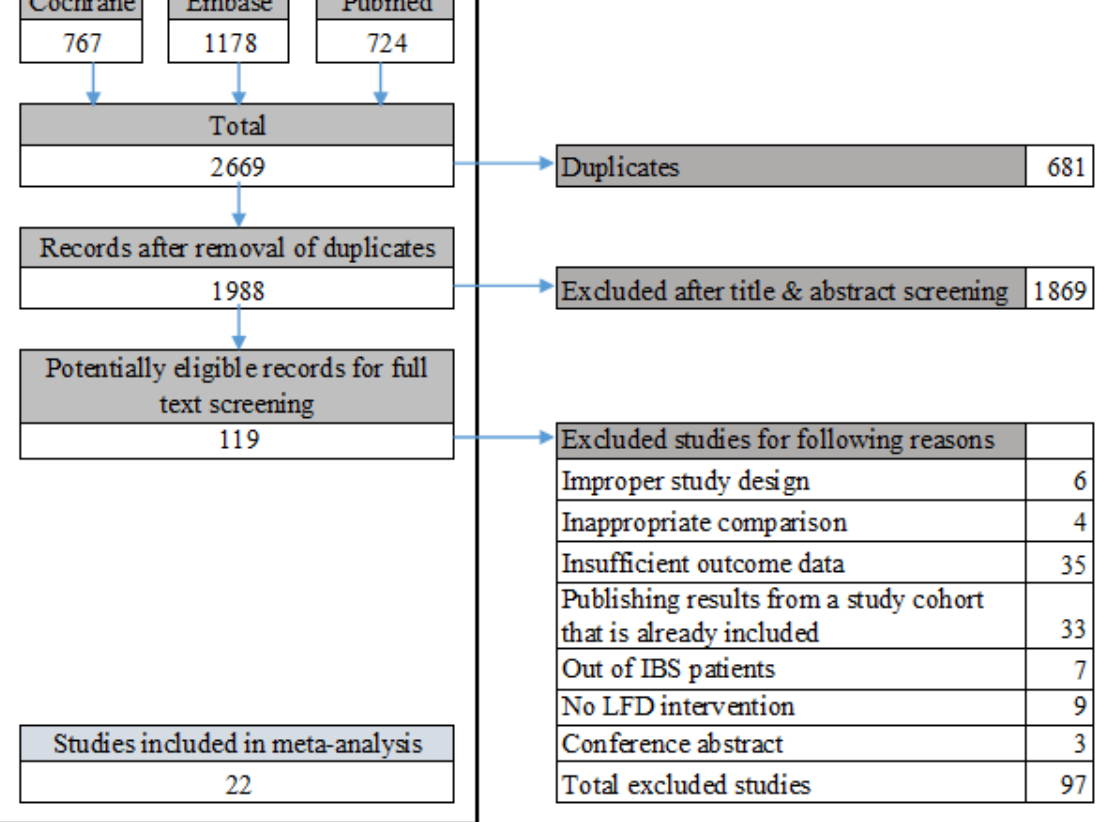
Figure 1. Identification and selection of the studies in the databases. LFD, low fermentable oligo-, di-, and monosaccharide and polyol diet.